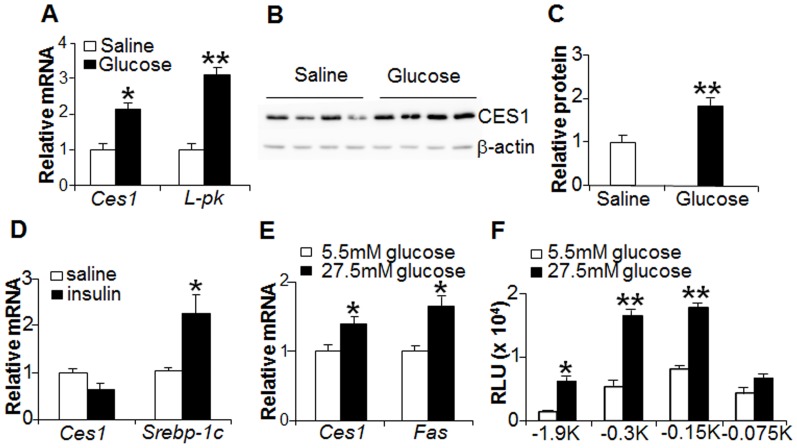
Hepatic CES1 is regulated by glucose but not insulin.(A–C) C57BL/6 mice were fasted for 16 h, followed by gavage with saline or glucose (8 g/kg) (n = 6 mice per group). Three hours after second oral gavage, hepatic mRNA levels (A) and protein levels (B) were determined. Hepatic CES1 protein levels were quantified (C). L-PK serves as a positive control in (A). (D) C57BL/6 mice were fasted for 16 h, followed by i.p. injection of either saline or insulin (0.8 units/kg) (n = 5 mice per group). After 3 h, mice were euthanized. Srebp-1c serves as a positive control. (E) Mouse primary hepatocytes were isolated and cultured in dulbecco's modified eagle medium (DMEM) plus 10% fetal bovine serum (FBS) overnight, followed by serum-free fasting for 8 h. Cells were then treated with either normal (5.5 mM) or high (27.5 mM) glucose for additional 24 h prior to quantification of mRNA levels. Fas serves as a positive control. (F) CES1 promoter-luciferase constructs were transfected into HepG2 cells, then treated with 5.5 mM or 27.5 mM glucose. After 36 h, luciferase activity was determined. Srebp-1c, sterol response element binding protein-1c. L-PK, liver type pyruvate kinase. Fas, fatty acid synthase. RLU, relative luciferase units. *p<0.05, **p<0.01.